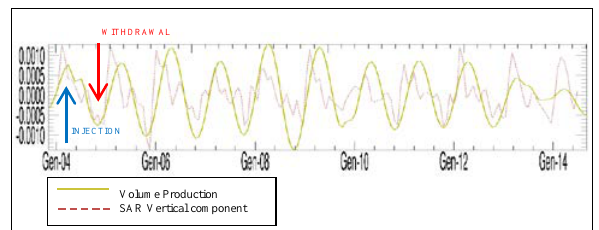
Figure 8. SAR time series (vertical component) compared with volume production (blue arrow: injection and rebound, red arrow: withdrawal and land subsidence) 5.2.5